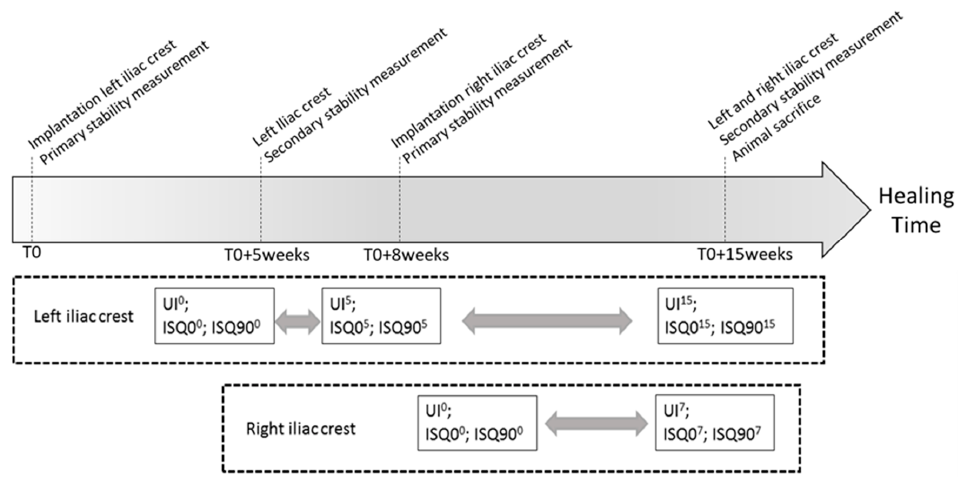
Figure 5. Schematic representation of the surgical protocol. The grey arrows indicate the comparison between the different healing times performed herein.